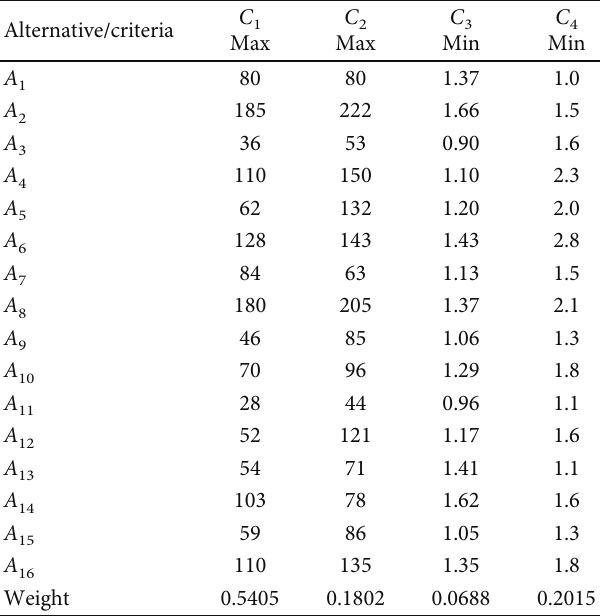
Table 1: Input decision-making